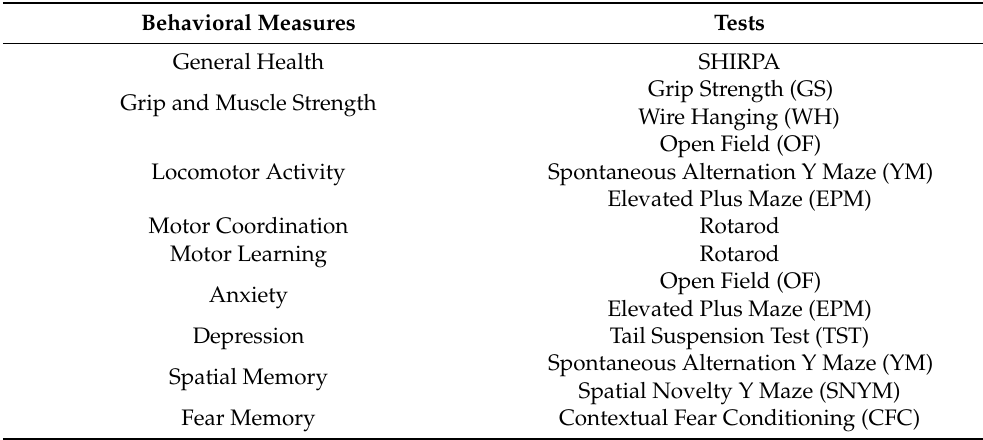
Table 1. Behavioral tests. Overview of neurobehavioral functions and their associated test in the test battery. Note, this does not reflect the order in which tests were